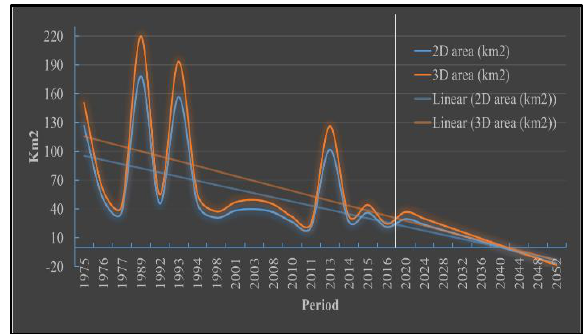
Figure 6. The forecasted potential glacier area of Ikh Turgen Mountain from 1975 to